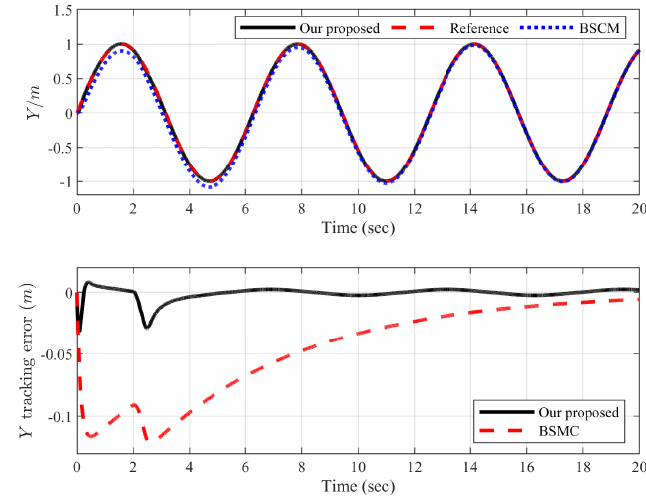
Figure 6. The control performance and tracking errors in relation to x .